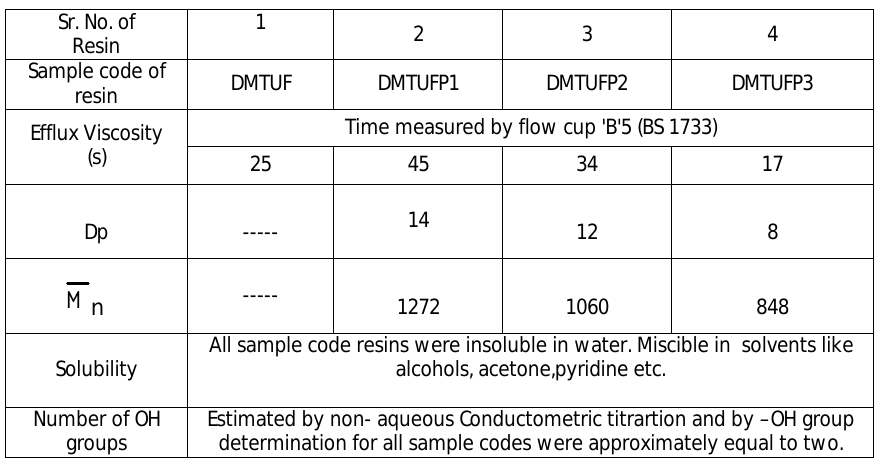
Table 3Table 3 Curing characteristics of the DMTUFP-HMTA systems at 10 K min –1 Sr. No.